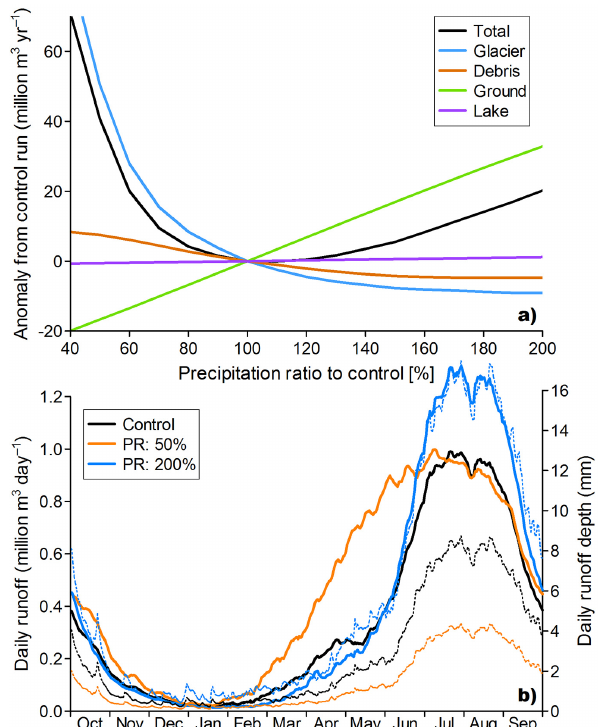
Figure 11. (a) Response of annual runoffs to changing precipita- tion ration against the control condition and (b) seasonal cycles of total runoff (thick lines) and precipitation (thin dotted lines) in the two extreme cases of the Tsho Rolpa Glacial Lake–Trambau Glacier basin calculated for the period 1979–2007 (28 years). Response in (a) is described by the anomaly with respect to the control calcula-